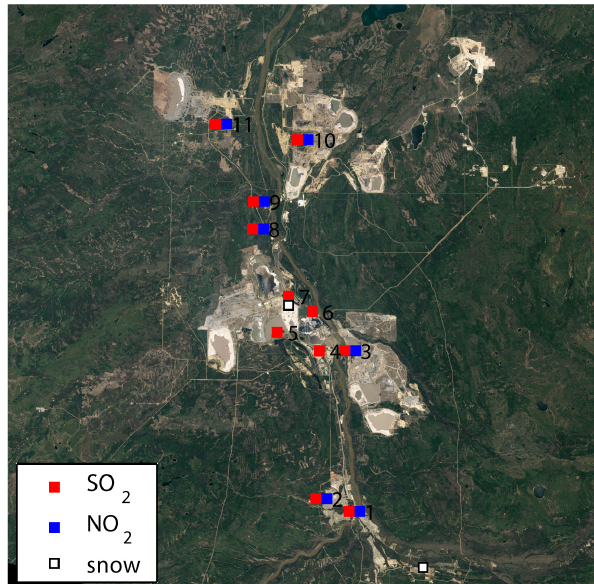
Fig. 9. Map of Wood Buffalo Environment Association (WBEA) monitoring stations and the parameters measured (http://earthobservatory.nasa.gov/Features/WorldOfChange/ athabasca.php?all=y). A 12th site (Fort Chippewyan), measuring SO 2 and NO 2 , is located approximately 160km north of site 10. Additional information on these sites can be found in the Supplement.